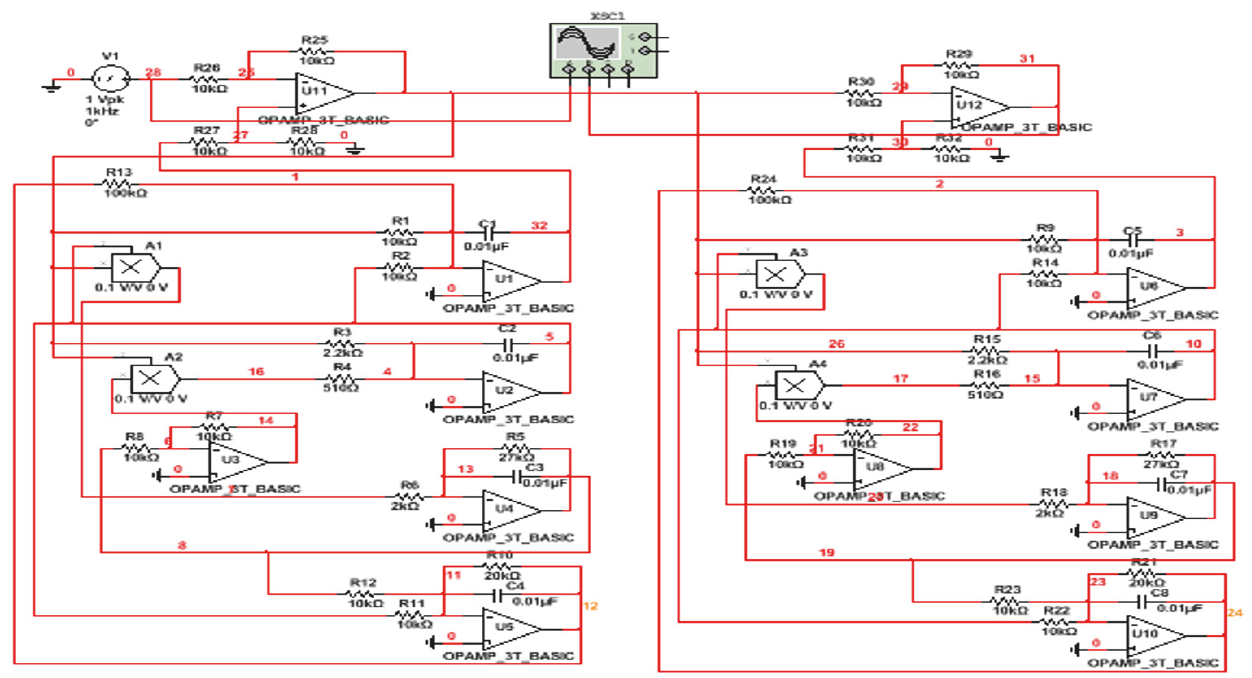
Figure 15: A novel hyperchaotic secure communication circuit by Multisim.